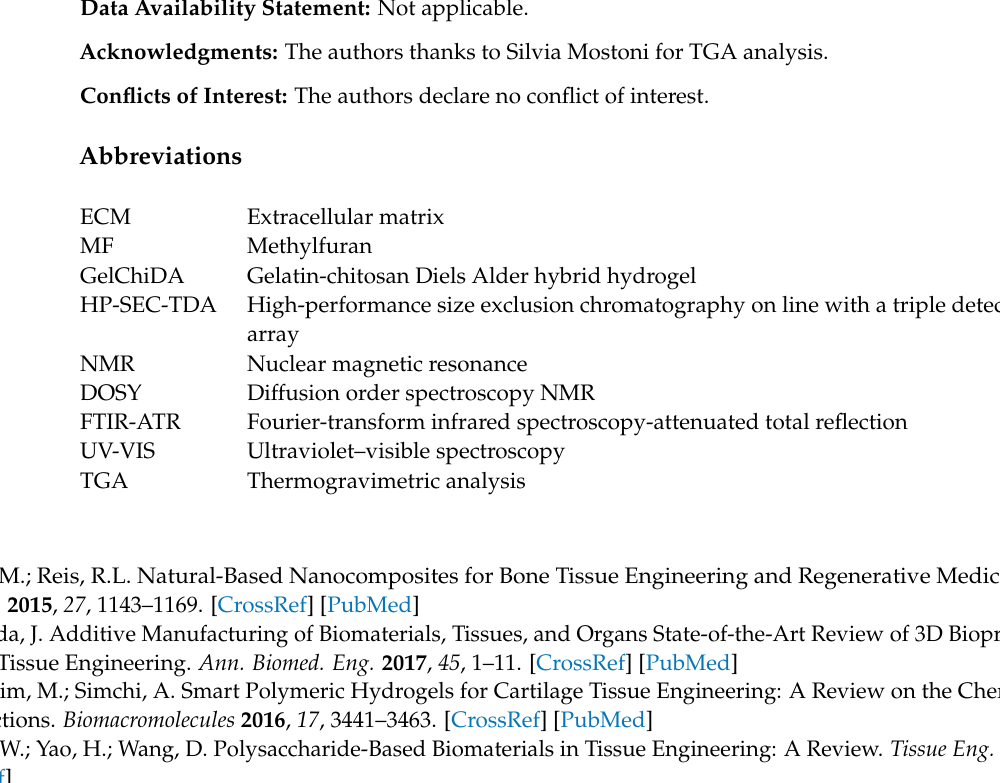
Figure S3: HSCQ—chitosan-MF, Figure S4: gHMBC—chitosan-MF, Figure S5: 1 H-NMR—gelatin-MF, Figure S6: 13 C-NMR—gelatin-MF, Figure S7: gHMBC—gelatin-MF, Figure S8: 1 H-NMR—4-arm- PEG10K-Maleimide, Figure S9: 1 H-NMR—integrals of hydrogel at different